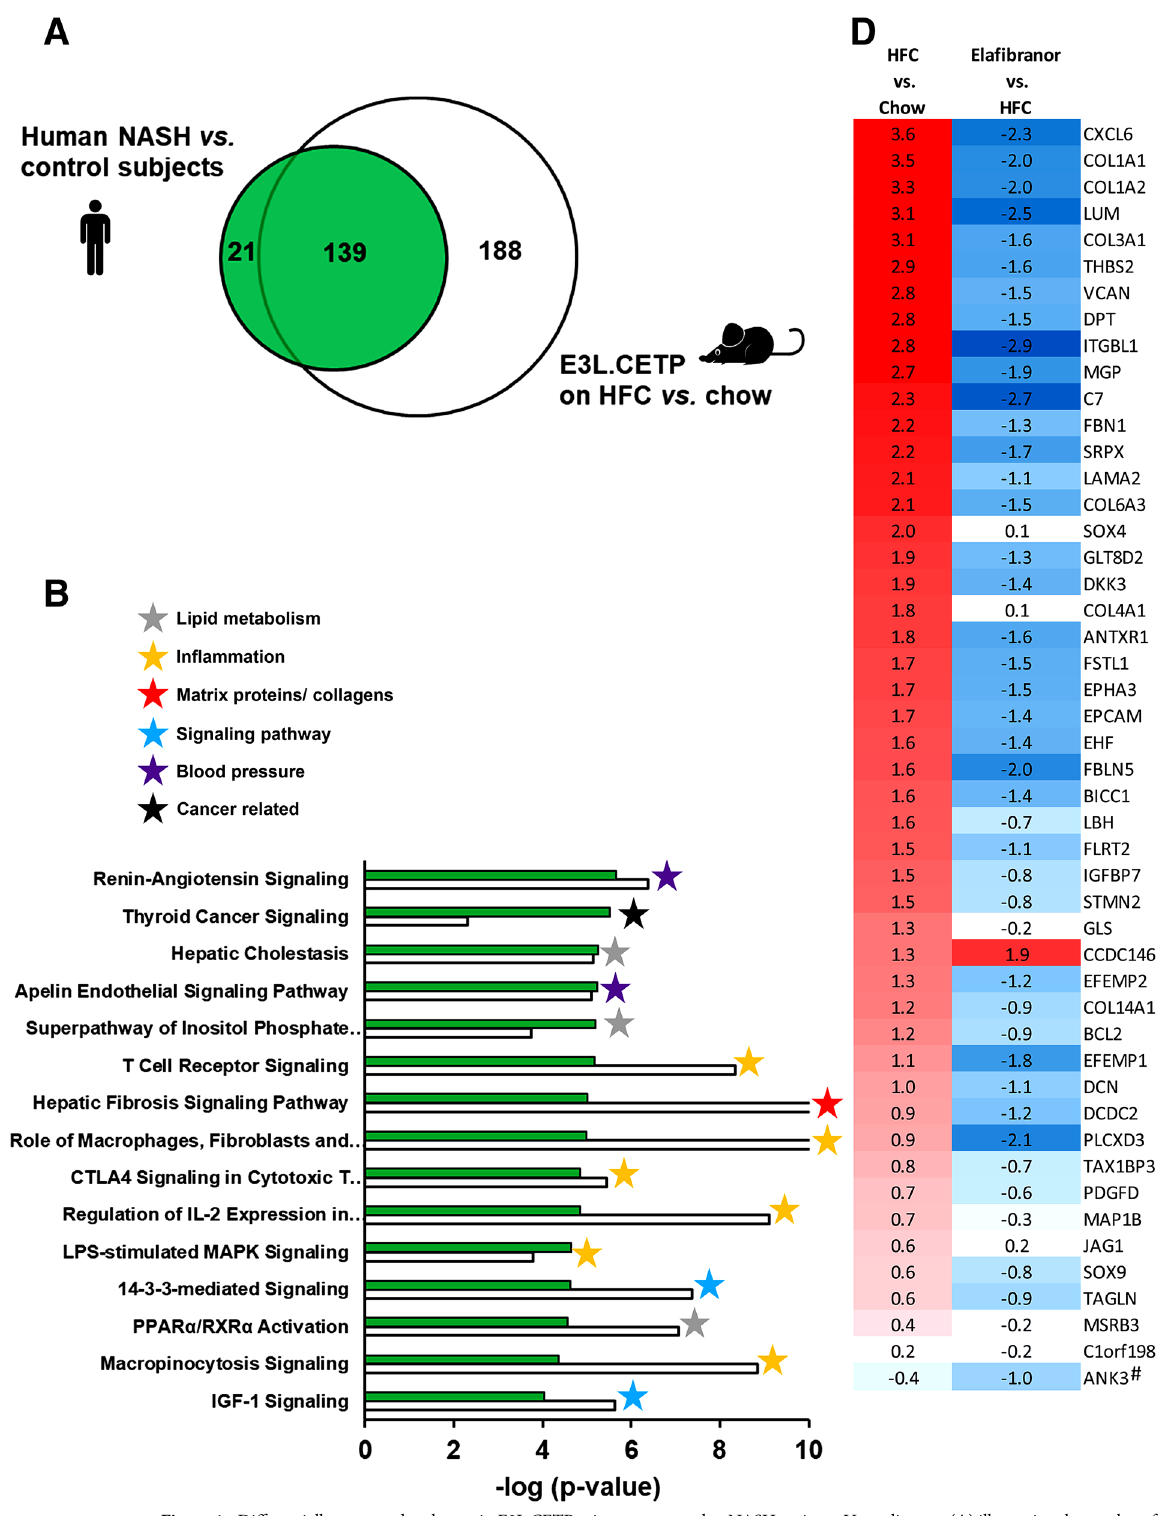
Figure 4. Differentially expressed pathways in E3L.CETP mice as compared to NASH patients. Venn diagram ( A ) illustrating the overlap of differentially expressed pathways (pathway p -val < 0.01) of livers between E3L.CETP mice fed a HFC diet vs. healthy chow diet for 25 weeks (white circle) and human NASH patients vs. healthy control subjects (green circle). The top 15 of significantly enriched pathways (−log( P - value)) for the genes affected in NASH patients (green bars) and the enrichment of E3L.CETP mice on HFC diet herein (white bars) ( B ). P -values equal to or smaller than −log( P value) of 10 are shown as 10. The top 15 of significantly enriched pathways (−log( P -value)) for the genes uniquely affected in E3L.CETP mice (white bars) and the (non-significant) enrichment of NASH patients plotted herein ( C ). P -values equal to or smaller than −log( P value) of 3 are shown as 3. Heatmap ( D ) showing recapitulation in E3L.CETP mice, as well as in response to elafibranor treatment, of hepatic gene expression profile that differentiates NASH patients with mild fibrosis (stage F0 or 1) from severe fibrosis (stage F3 or 4) 42 . Red colour indicates upregulation and blue colour indicates down-regulation. Gene with # indicates gene with differential regulation in mice as compared to human